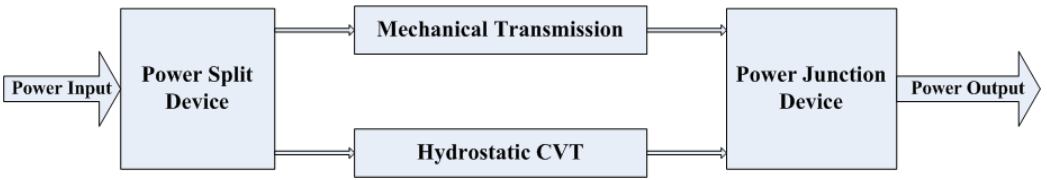
Figure 1. Composition of the hydro-mechanical continuously variable transmission (HMCVT).